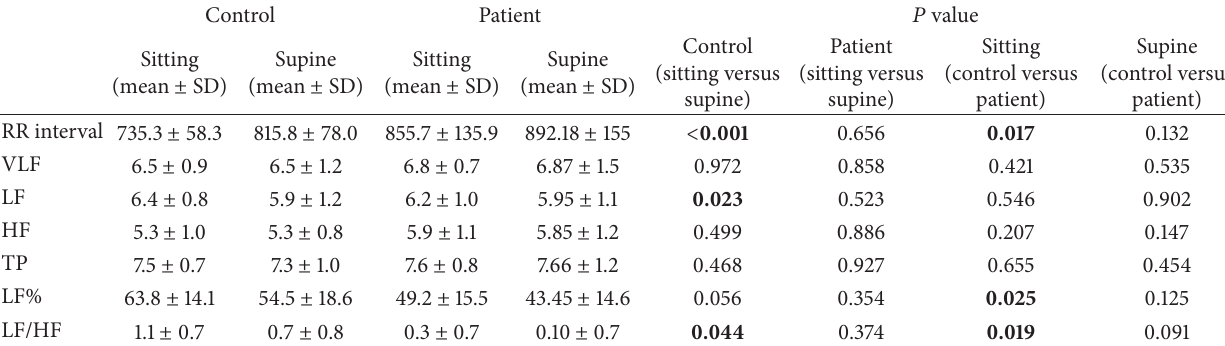
Figure 1: (a) RR interval, (b) LF%, and (c) LF/HF in the sitting position between the control and patient groups. ∗ 𝑃 < 0.05 . Table 2: Statistical comparison of HRV variables in control group and patient